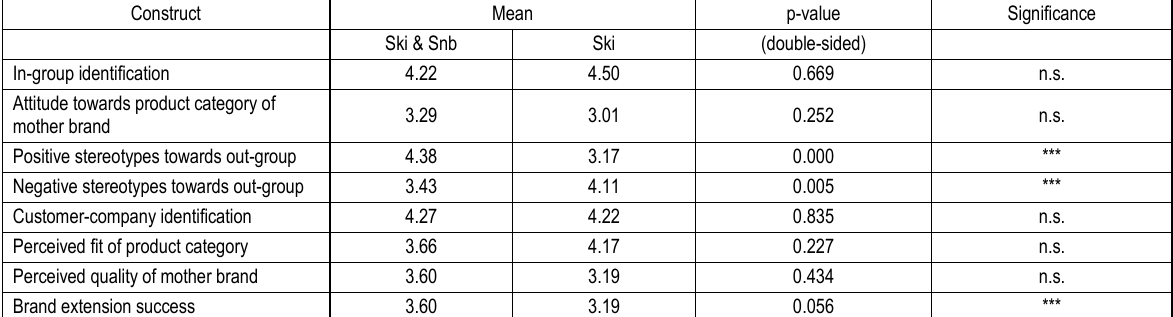
Table 5. T-test for verifying significant differences of the mean values of the multiple group comparison